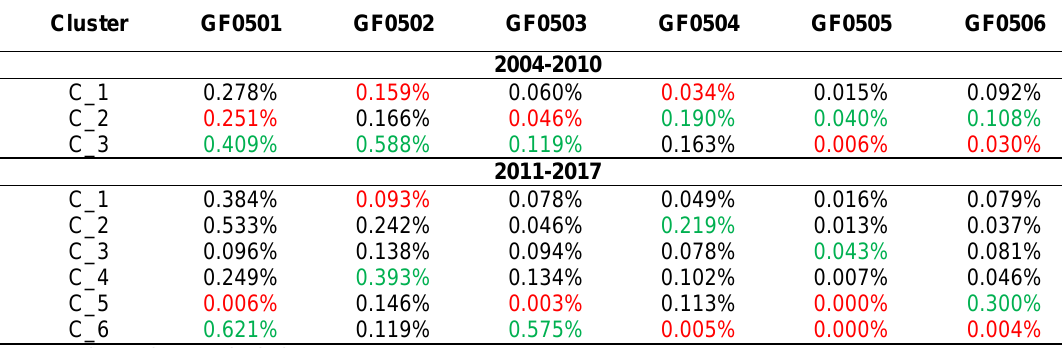
Table 3. Average amounts of public expenditure on particular aspects of environmental protection as a percentage of the